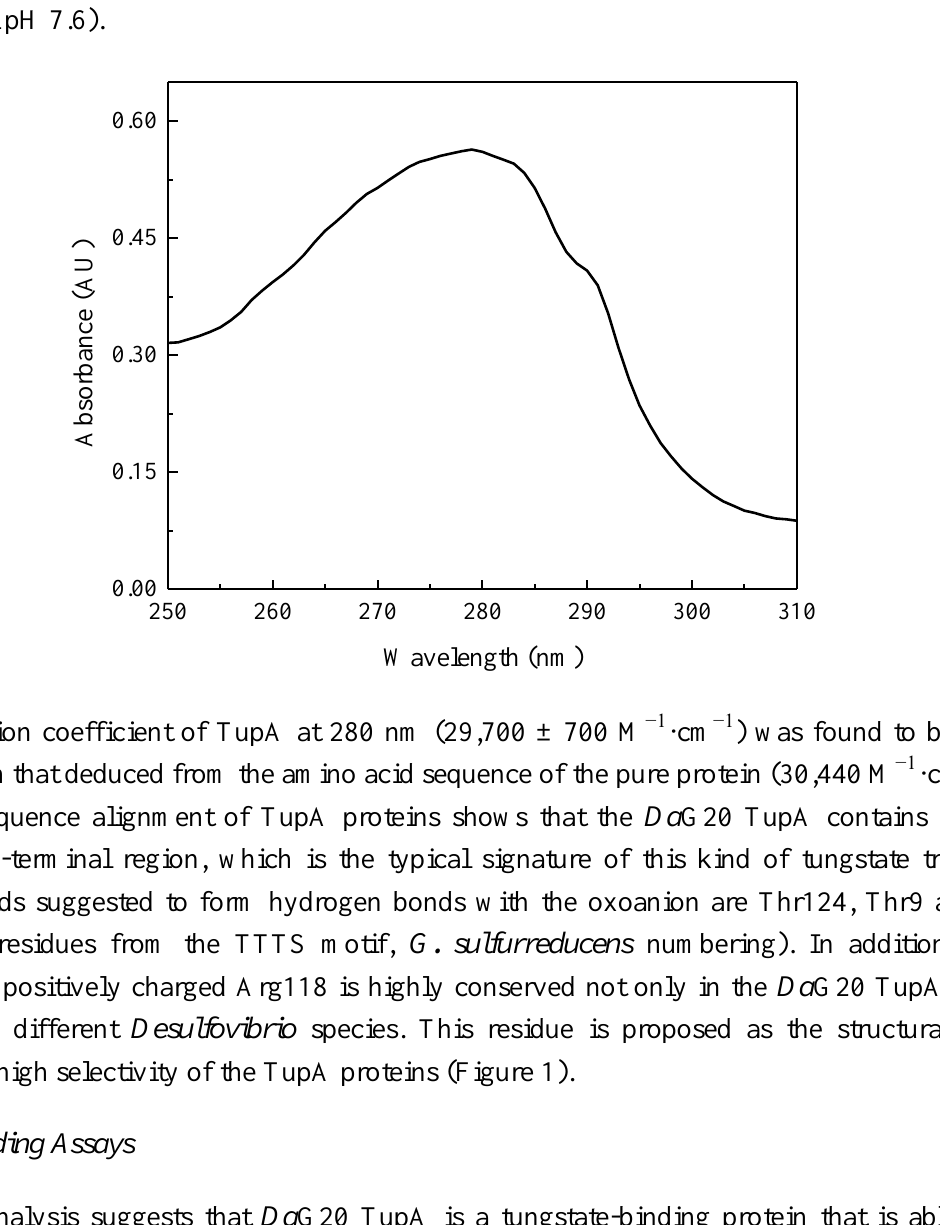
Figure 3. UV-visible spectrum of as isolated TupA protein (0.020 µM protein in 50 mM Tris-HCl pH